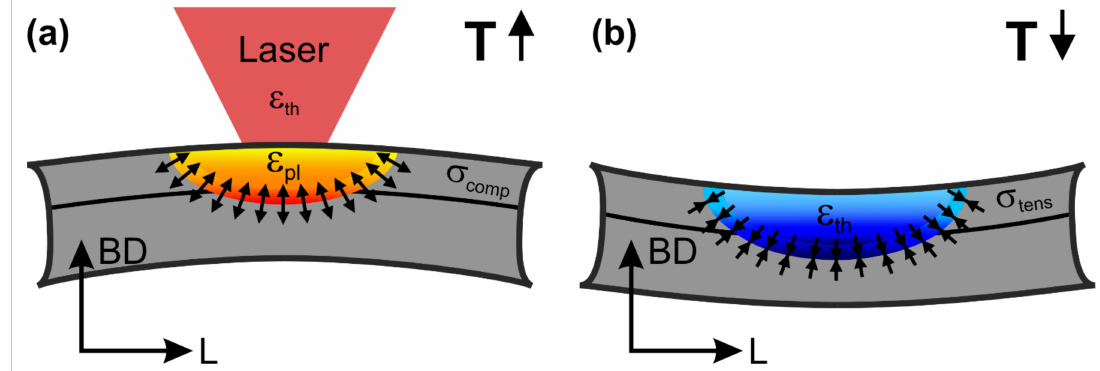
Figure 3. Schematic images showing the effect of the heat input on the stress state during ( a ) heating and ( b ) cooling in LPBF manufacturing (adapted from [60]).